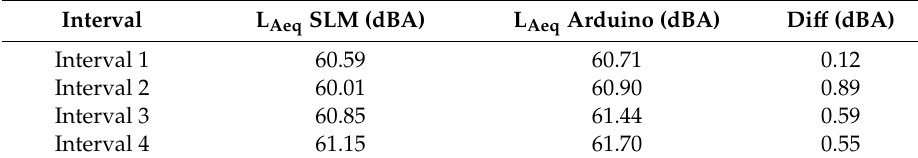
Table 6. The SLM and Arduino Due measurements in an urban street.